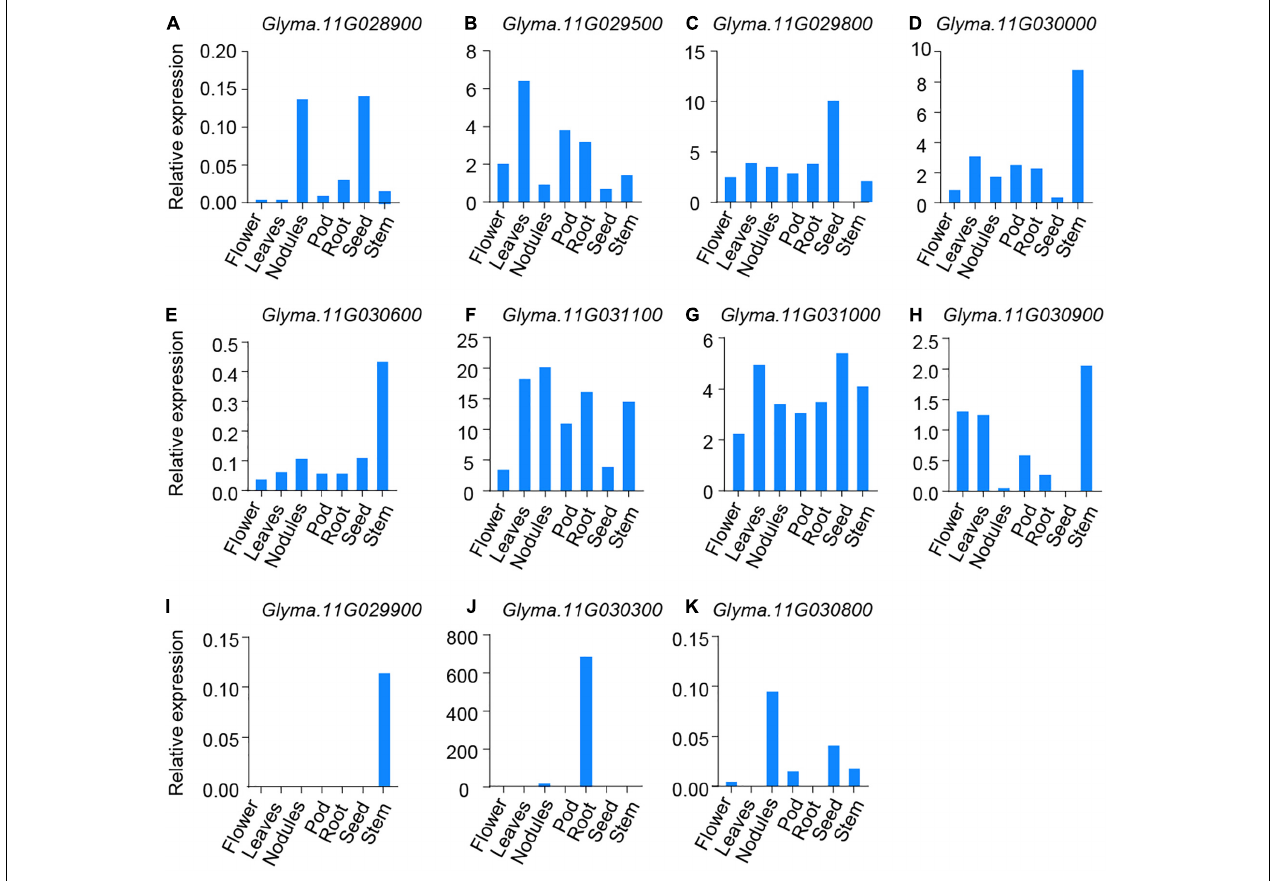
FIGURE 5 | Expression of eleven candidate genes in different soybean tissues. (A–K) The expression of Glyma.11G028900 , Glyma.11G029500 , Glyma.11G029800 , Glyma.11G030000 , Glyma.11G030600 , Glyma.11G031100 , Glyma.11G031000 , Glyma.11G030900 , Glyma.11G029900 , Glyma.11G030300 , and Glyma.11G030800 in different soybean tissues (flower, leaves, pod, stem, nodule, seed, and root) obtained from an RNA-seq database. Values are mean ± s.e.m. ( n = 3 biologically independent samples).